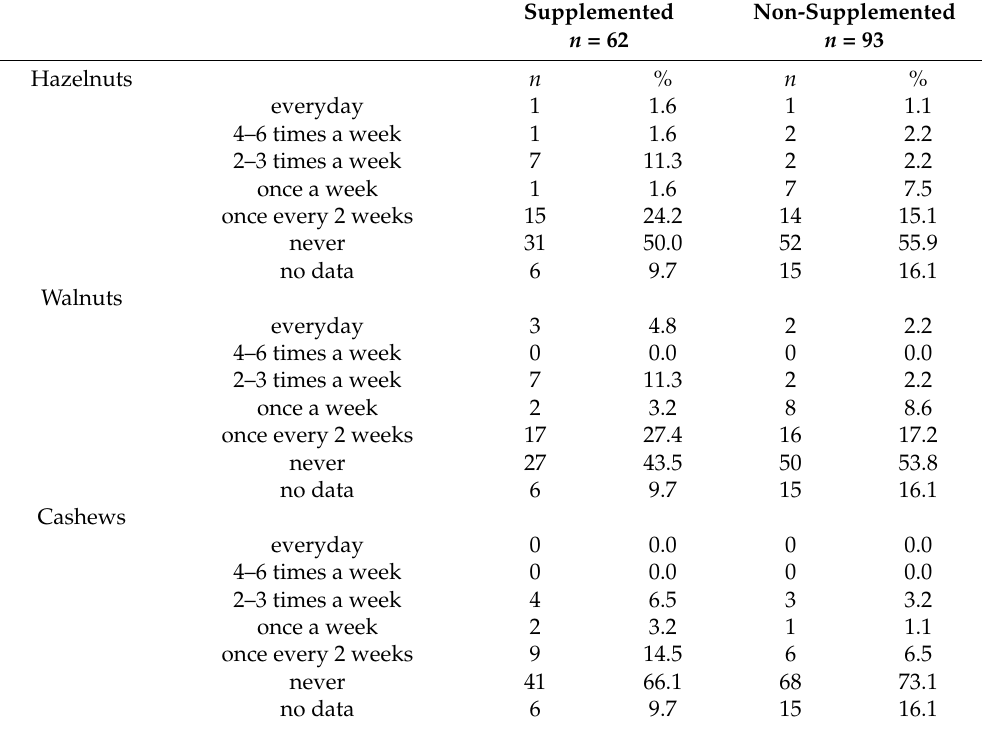
Table A4. Nuts consumption among investigated